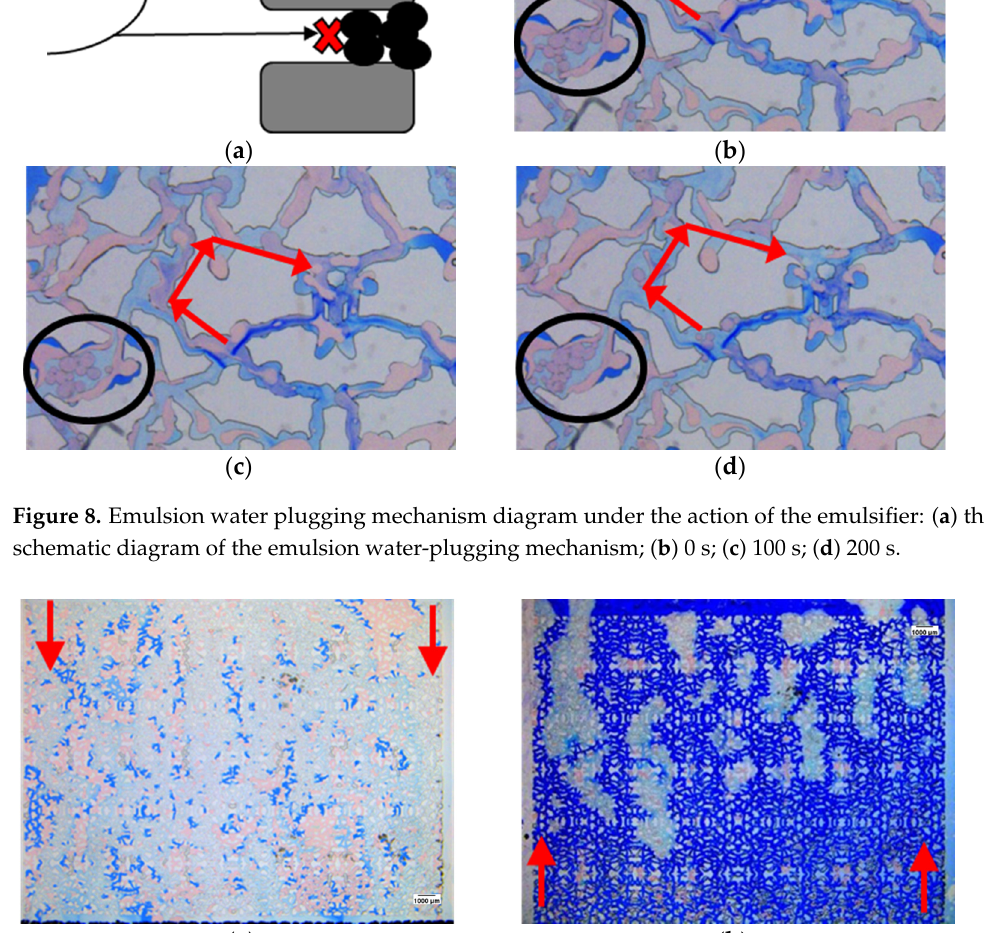
Figure 9. The subsequent water invasion process diagram after polymer microsphere injection and microsphere expansion in the homogeneous model. ( a ) The microsphere is injected along the simu- lated “horizontal wellbore”; ( b ) end of the second water